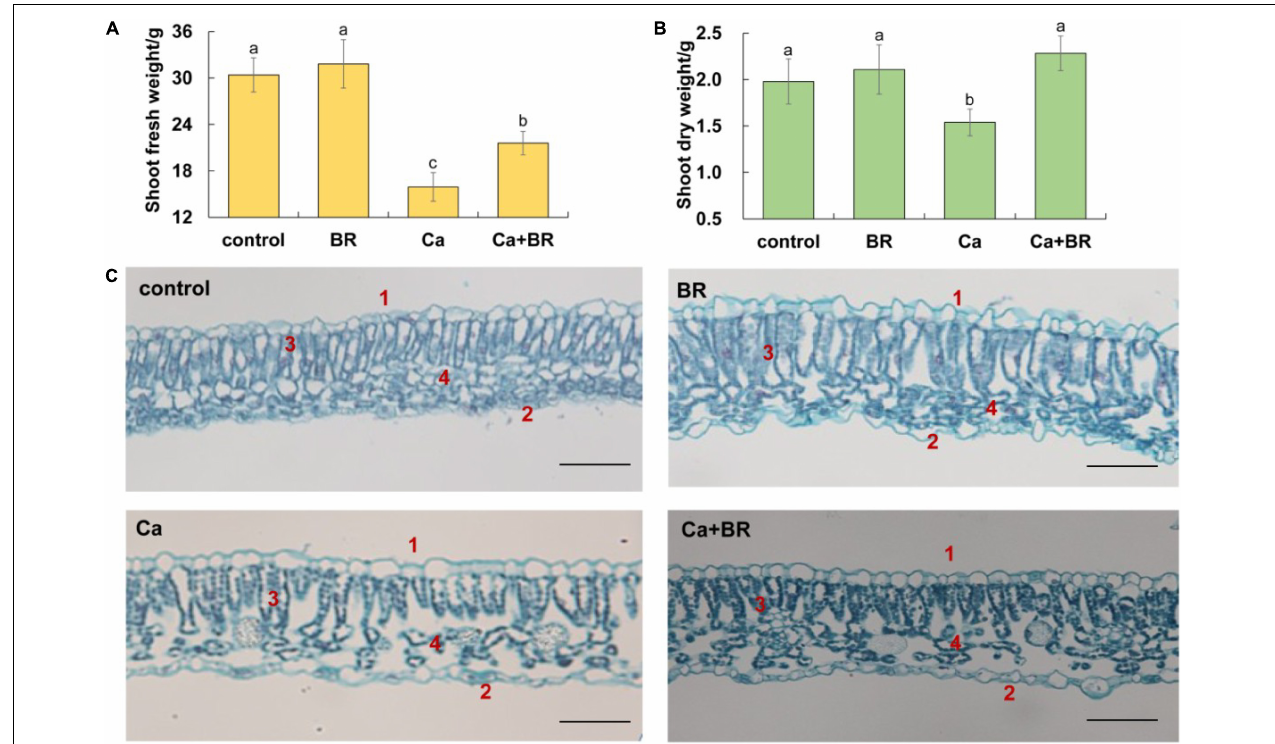
FIGURE 1 | Brassinolide alleviated calcium nitrate [Ca(NO 3 ) 2 ]-induced growth inhibition in tomato seedlings. (A) Shoot fresh weight. (B) Shoot dry weight. (C) Effects of brassinolide (BR) on the leaf microstructure in Ca(NO 3 ) 2 -treated tomato seedlings. 1, Upper epidermis; 2, Lower epidermis; 3, Palisade mesophyll; and 4, Spongy mesophyll. BR, 0.1 µ mol/L BR; calcium (Ca), 100 mmol/L Ca(NO 3 ) 2 ; Ca+BR, 100 mmol/L Ca(NO 3 ) 2 stress plus foliar spraying with exogenous BR. Each data point represents the mean of three independent biological replicates (mean ± SD). Different letters above the bars indicate statistically significant differences ( P < 0.05). Scale bars = 100 µ